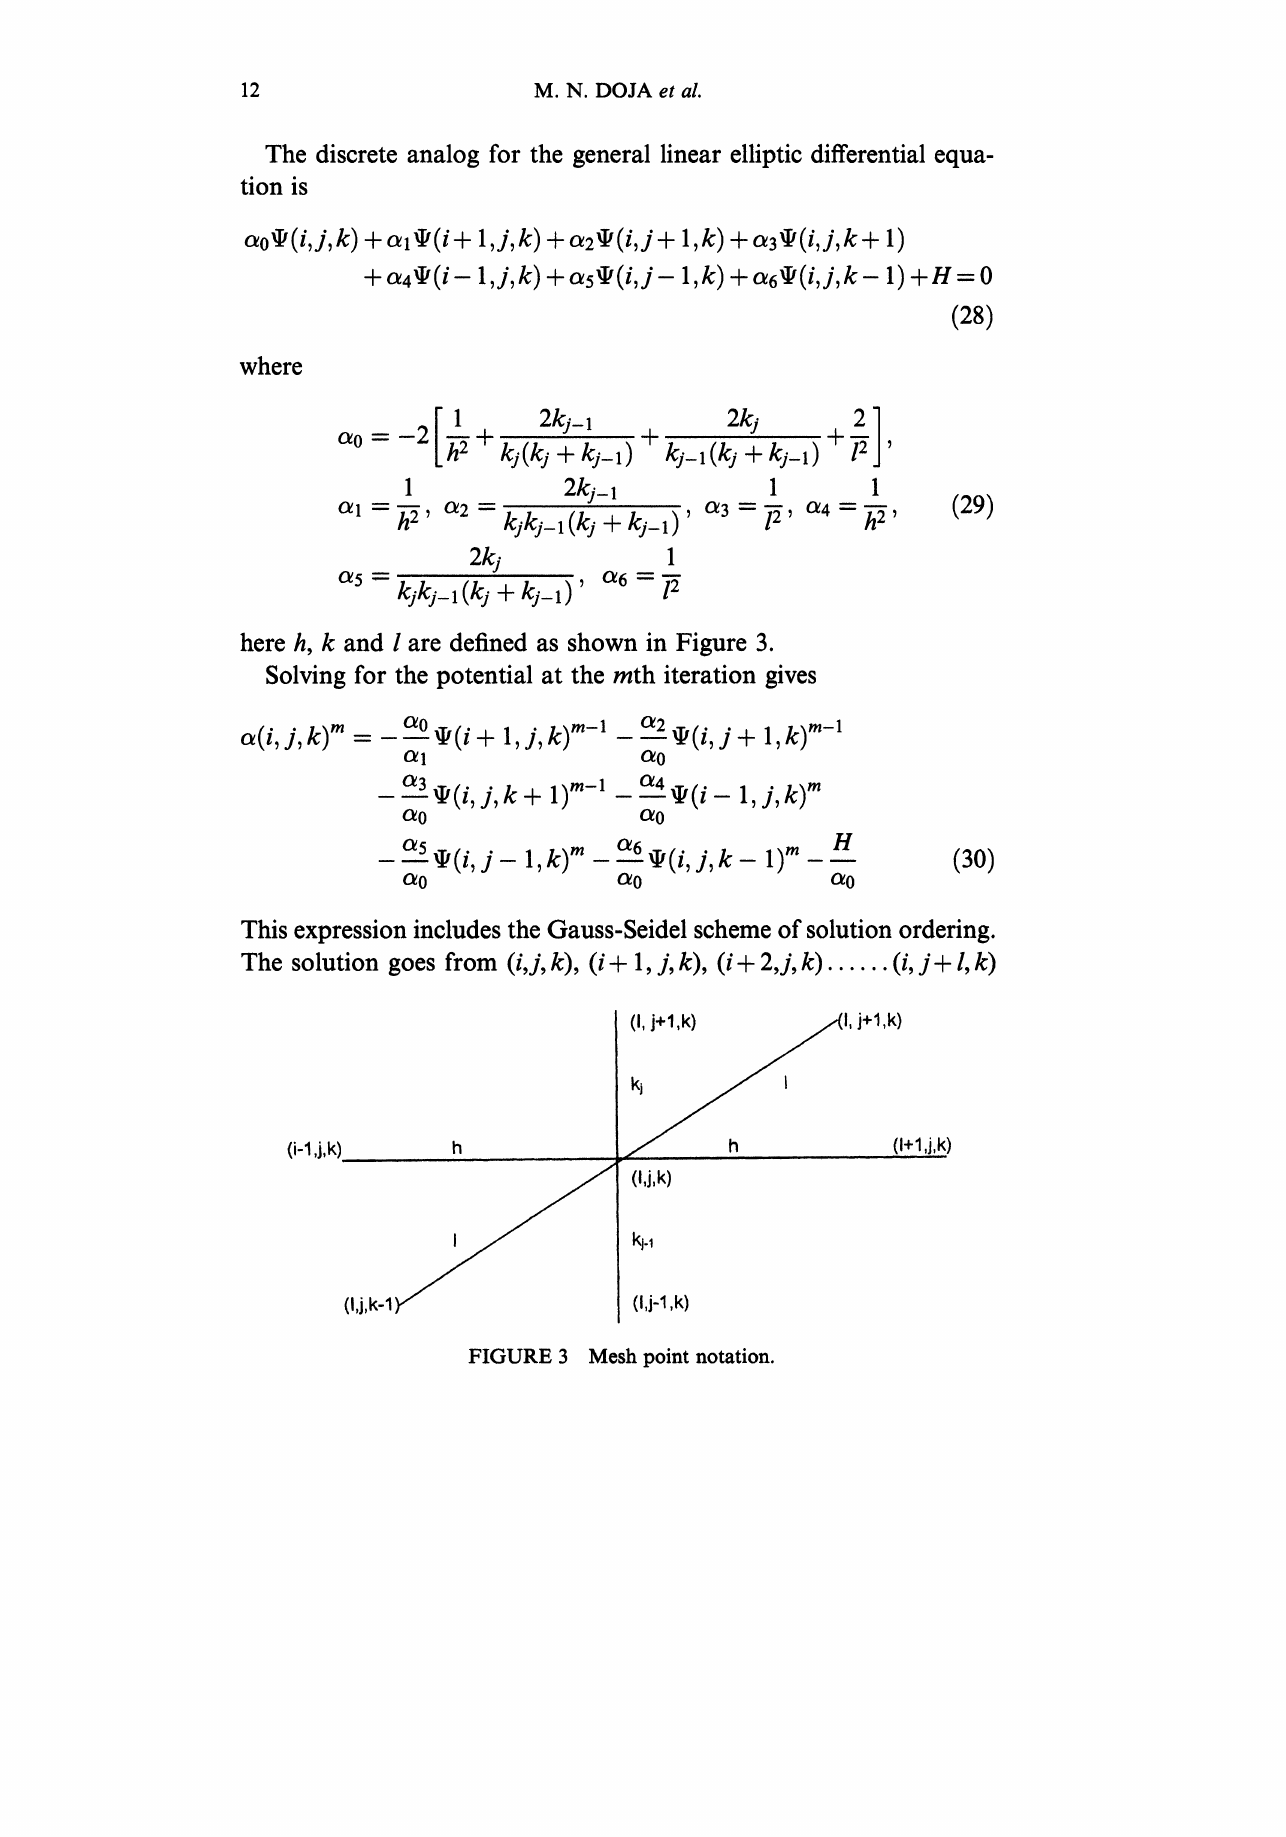
FIGURE 3 Mesh point